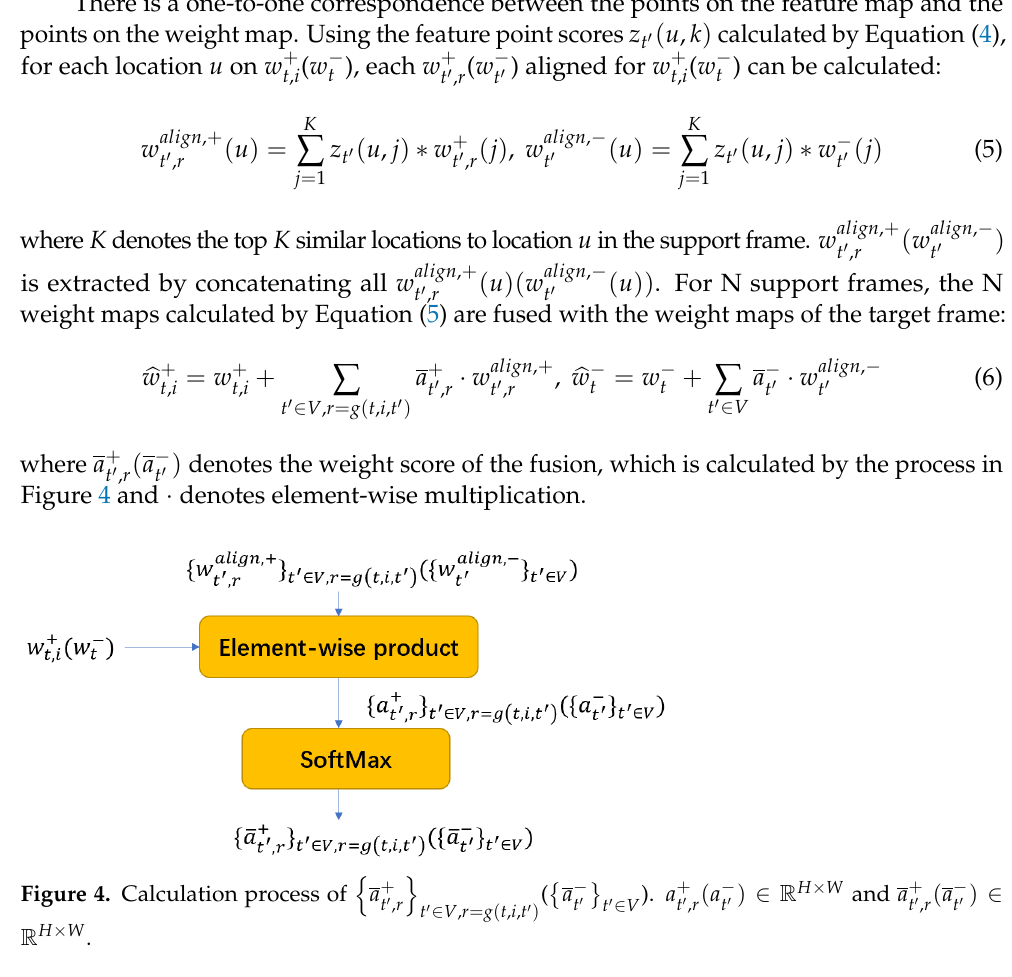
Figure 4. Calculation process of R H × W